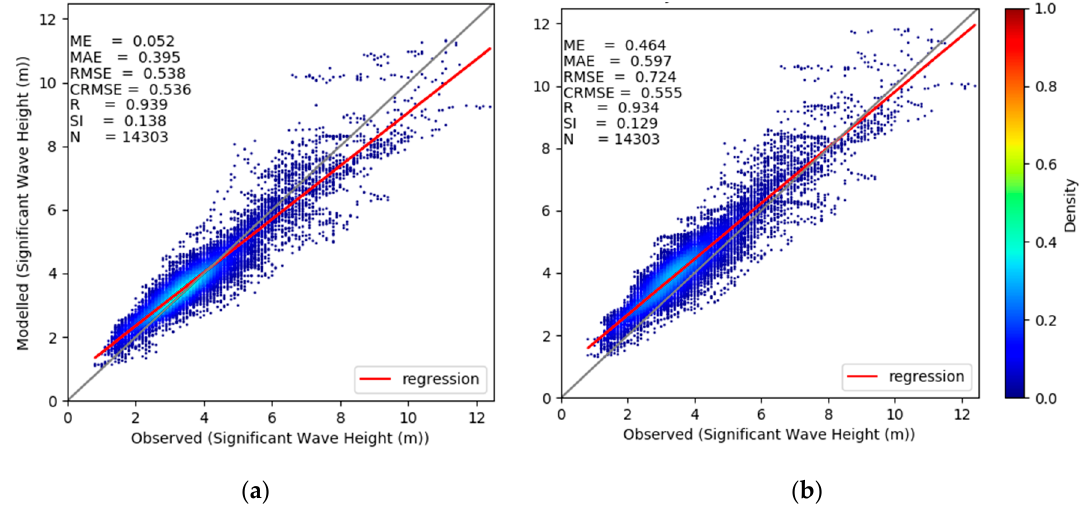
Figure 6. Correlation between co-located Altimetry measurements and the regional SWAN model results for ( a ) June M3 and ( b ) June M4.